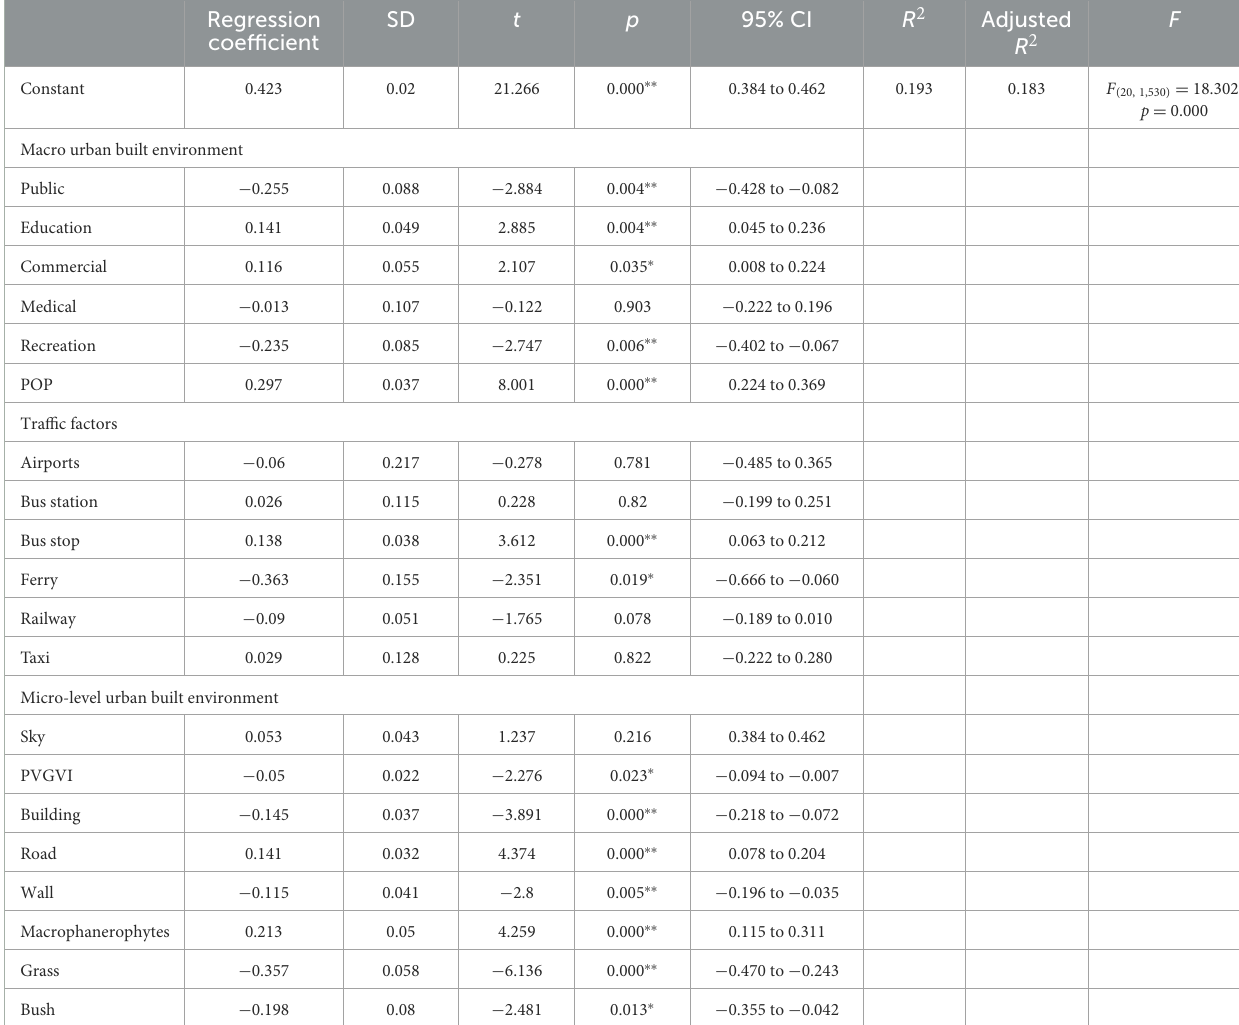
TABLE 4 Model 1: Robust regression results of CCC and urban built environment ( n = 1,551). Regression